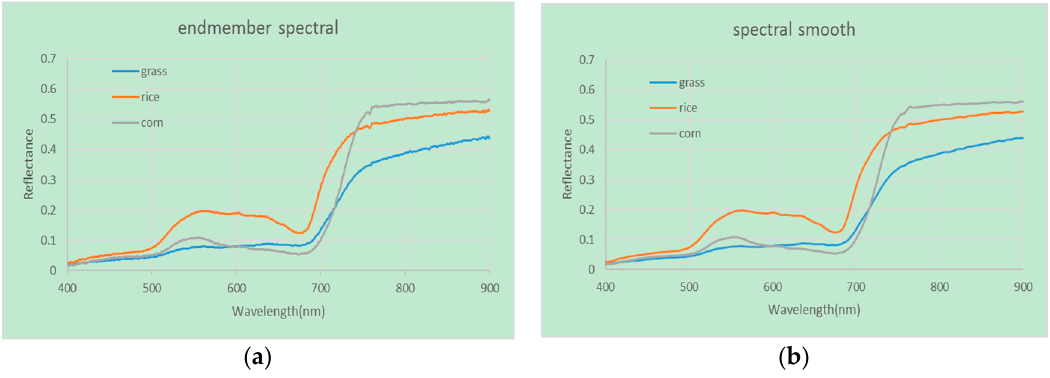
Figure 7. Spectra of rice, corn, and grass smooth results: ( a ) original spectra and ( b ) smooth results.